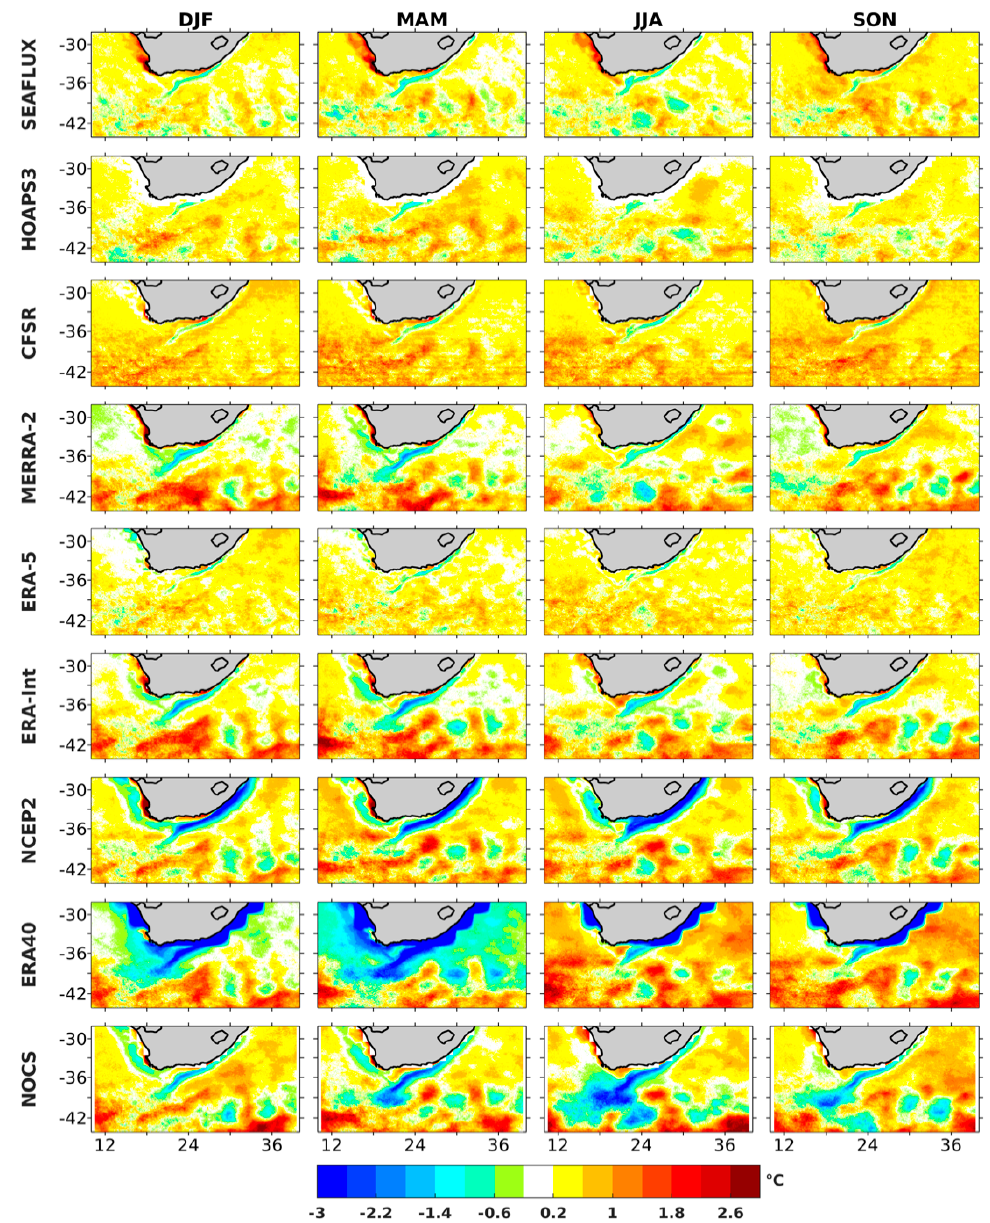
Figure 7. Mean seasonal di ff erences of SST ( ◦ C) between the observation-based, the reanalysis products, and MODIS. From left to right austral summer (DJF), austral autumn (MAM), austral winter (JJA) and austral spring (SON).